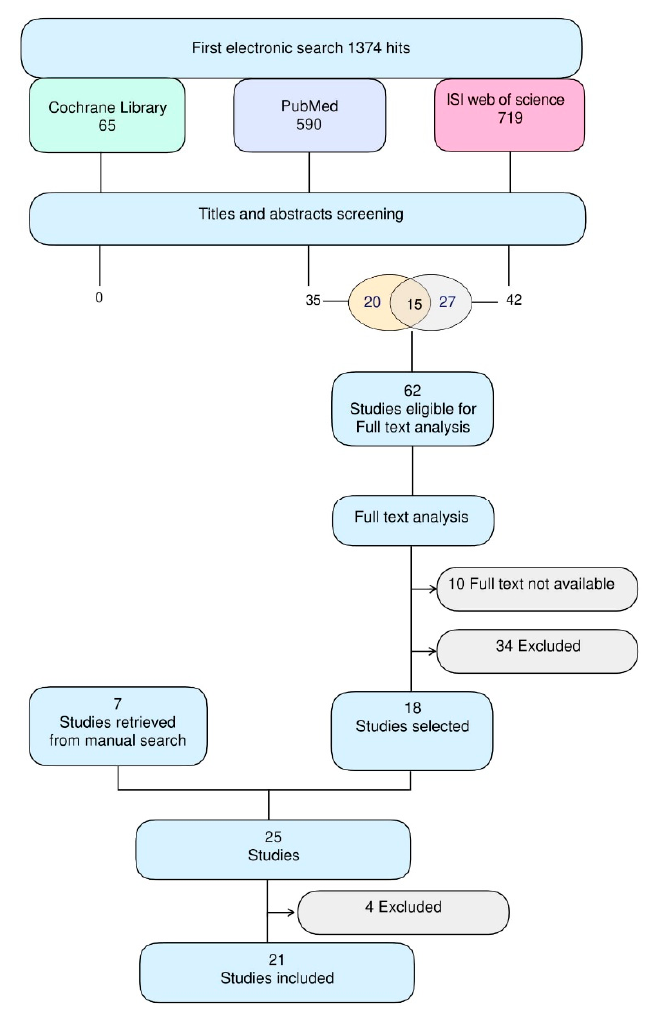
Figure 2. Flowchart of the review process.